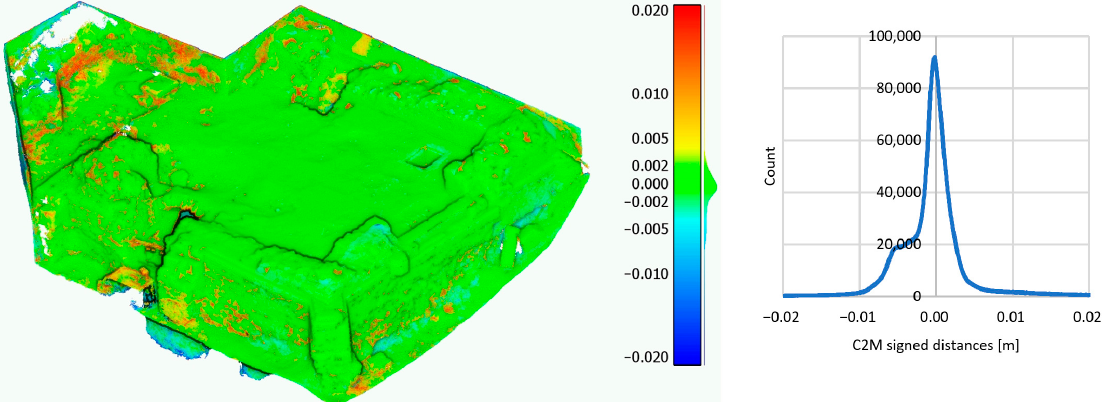
11 of 16 4.2. Photogrammetric Variants B, C, and D vs. the Reference Photogrammetric Variant A When comparing the photogrammetric variants, an effect of the relative change in the configuration of the camera network was only present in the ossuary, as there were